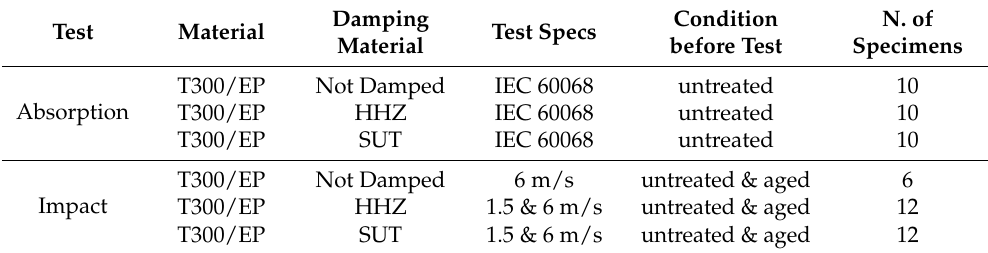
Table 2. Test configurations for T300/EP Composites and damped